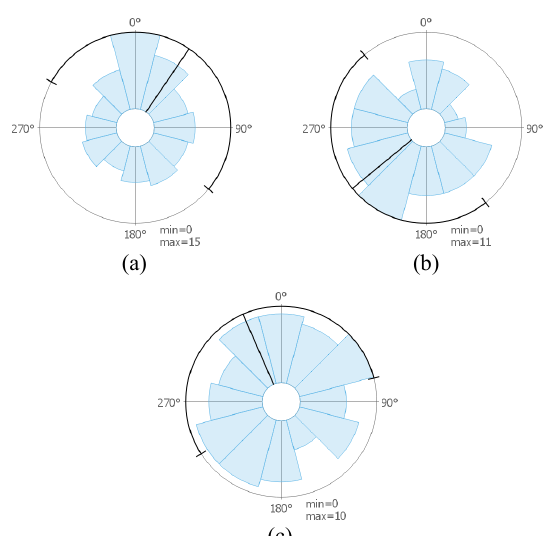
Figure 8. Rose plots showing microsaccade directions rotated toward the next fixation for a selection of participants from the painting data set. Participants whose microsaccades have a direction that (a) tend to be toward the next fixation, (b) toward the opposite direction, and (c) that are equally distributed toward each direction.